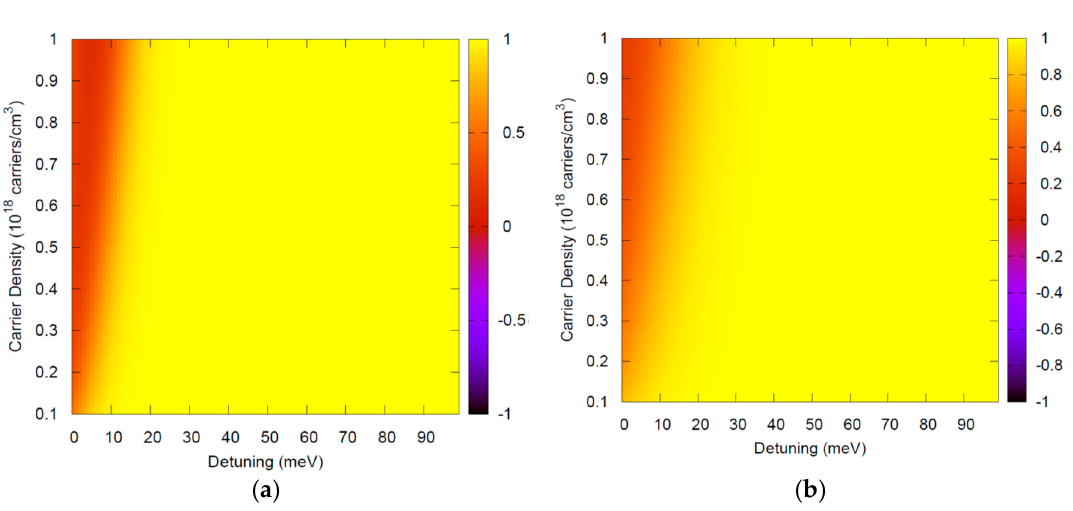
Figure 2. FF ( ω , ω (cid:48) ) , the term in curly braces in Equation (6) which has been approximated by FF ( ω , ω (cid:48) ) ≈ 1, evaluated at (cid:125) ω = E g for bulk GaAs at higher temperatures and high densities, where the dephasing Γ λ is larger than in the low temperature case. In this case a wider range of detunings ω − ω (cid:48) contribute to the integral in Equation (4). Thus, the range chosen in the x -axis is even larger than necessary. ( a ) T = 150 K, ( b ) T = 300